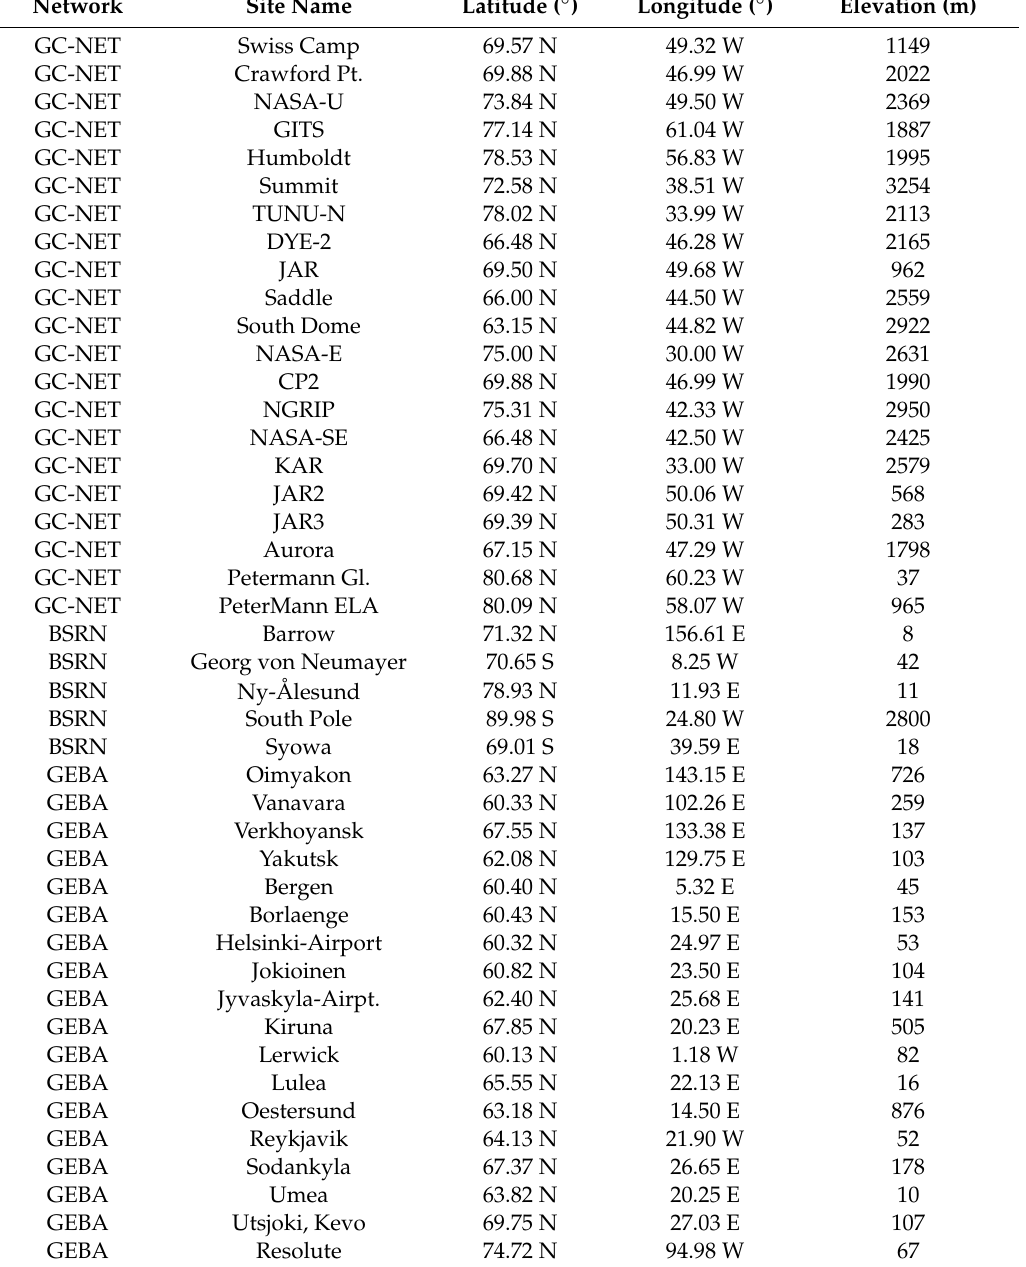
Table 2. Detailed information of the sites from GC-NET, BSRN, and GEBA used in this